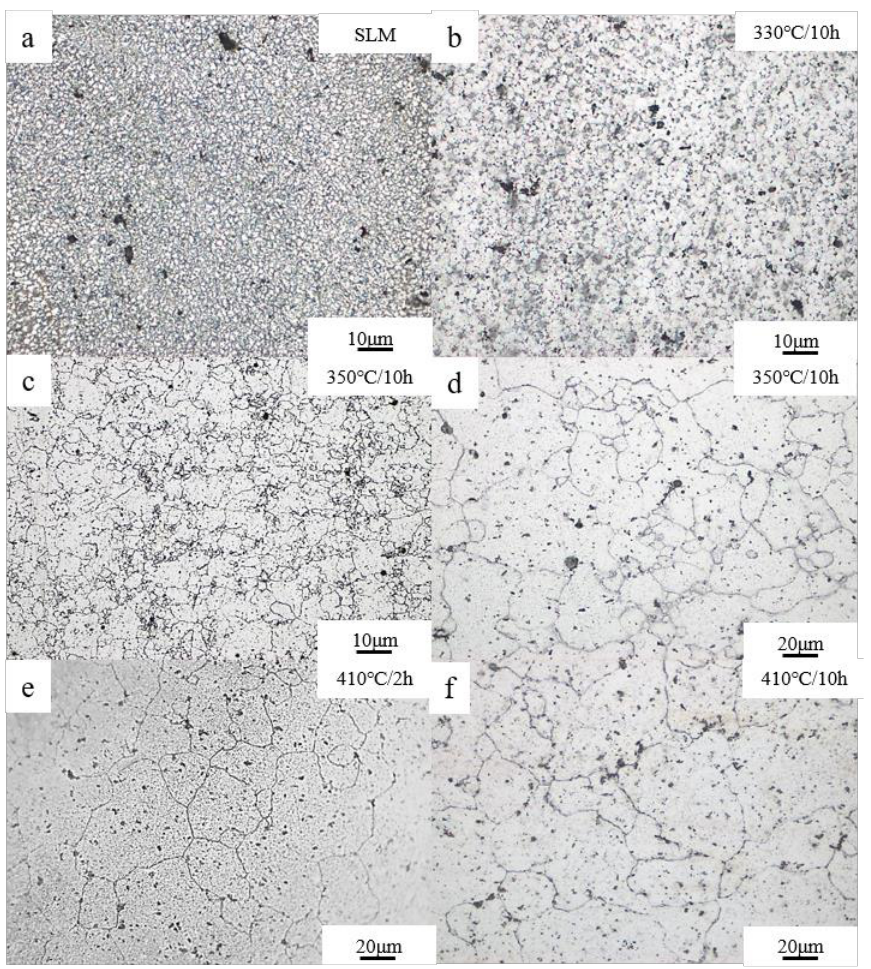
Figure 5. Optical microscopy microstructure of SLMed AZ61 prepared at different T4 temperatures and times: ( a ) SLMed AZ61; ( b ) 330 °C, 10 h; ( c ) 350 °C, 10 h; ( d ) high magnification of ( c ); ( e ) 410 °C, 2 h; ( f ) 410 °C, 10 h.